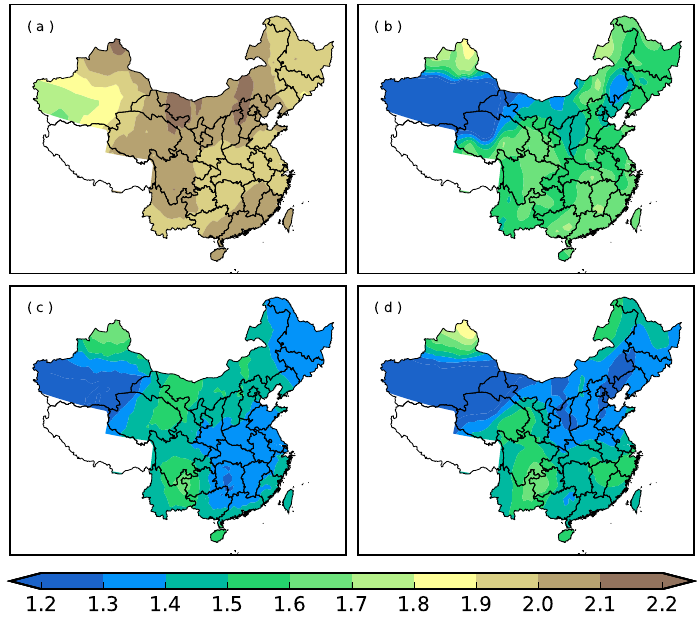
Figure 4. Distribution of drought characteristics: ( a ) mean drought duration; ( b ) mean drought severity; ( c ) standard deviation of drought duration; and ( d ) standard deviation of drought